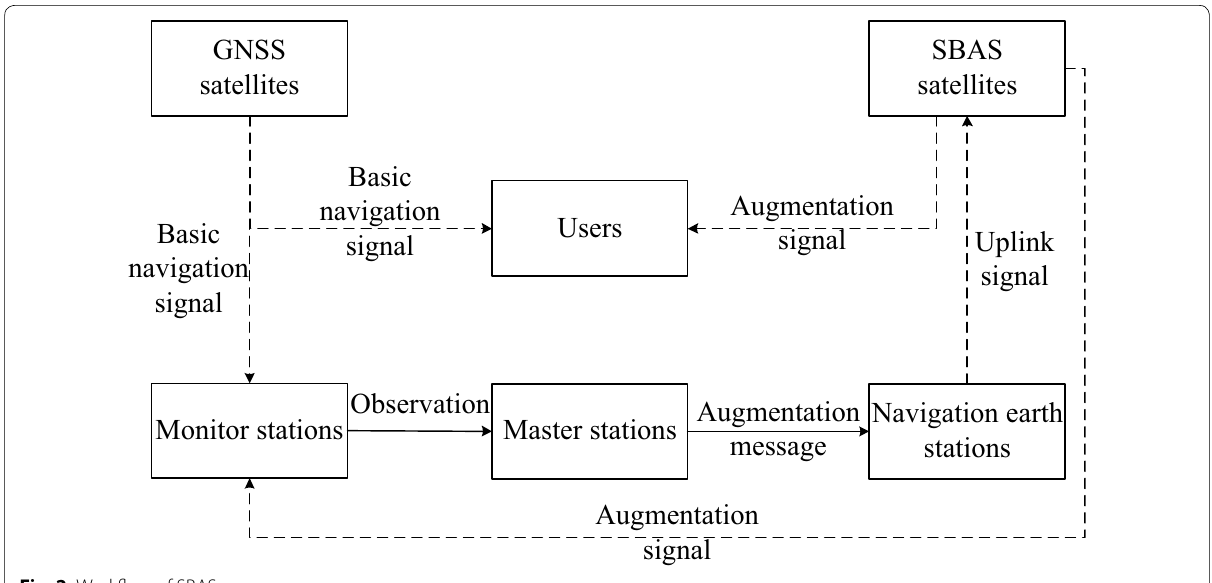
Fig. 2 Workflow of